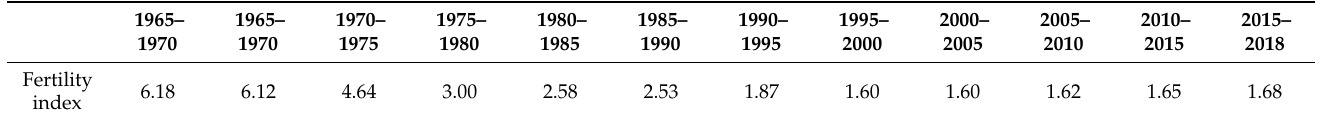
Table 4. Development of overall birth rate (fertility